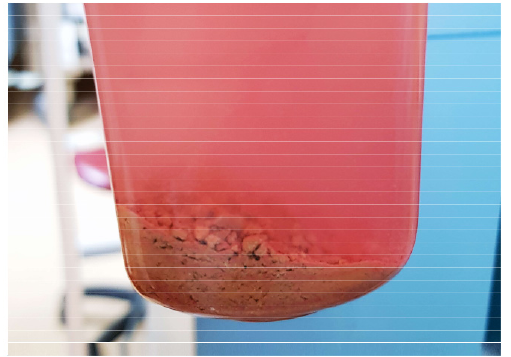
Figure 4. Overall stone-free rate in the Trilogy group. Table 3. Comparison of main surgical parameters between the two groups.